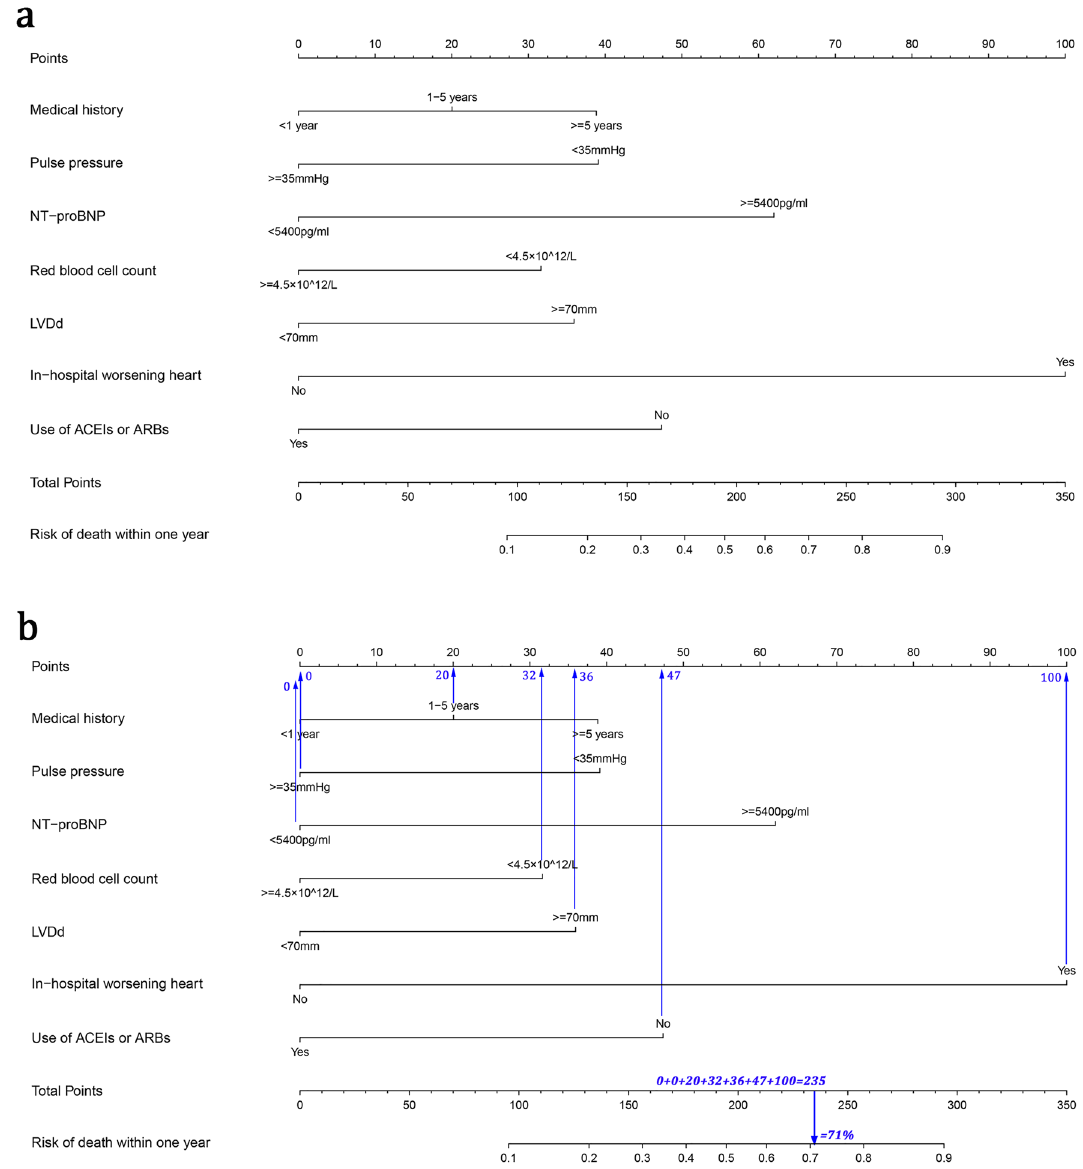
Figure 2. Nomogram for assessing the risk of death within 1 year in NIDCM patients. ( a ) Complete nomogram. ( b ) How to use the